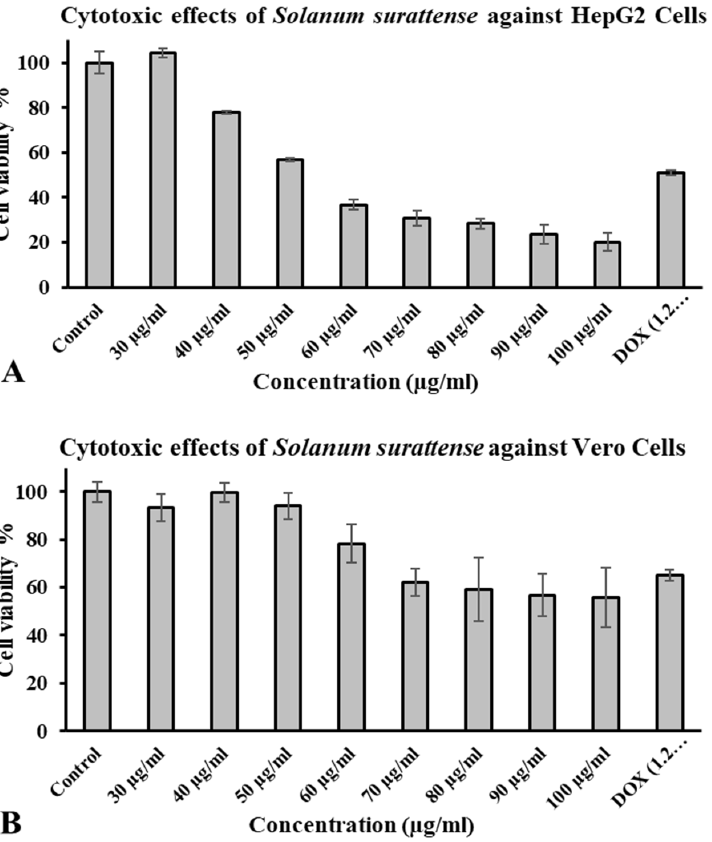
Figure 1. Cell viability % of S. surattense fruit extract and Doxorubicin as a positive control. ( A ) Anti ‐ cancer activity of S. surattense fruit extract on HepG2 cell viability. HepG2 cells treated with different